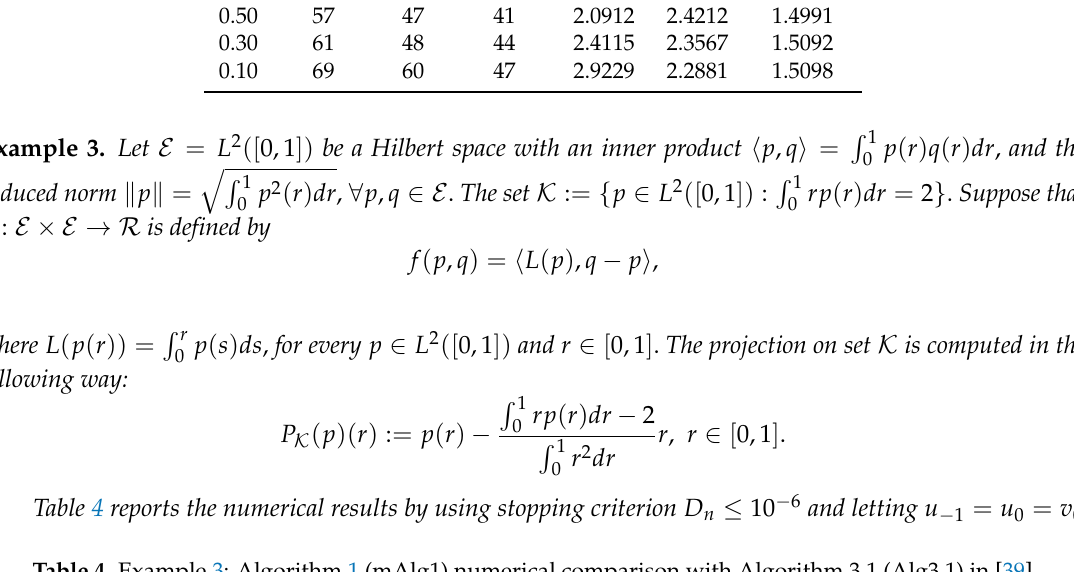
Table 4. Example 3: Algorithm 1 (mAlg1) numerical comparison with Algorithm 3.1 (Alg3.1) in [39] and Algorithm 1 (Alg1) in